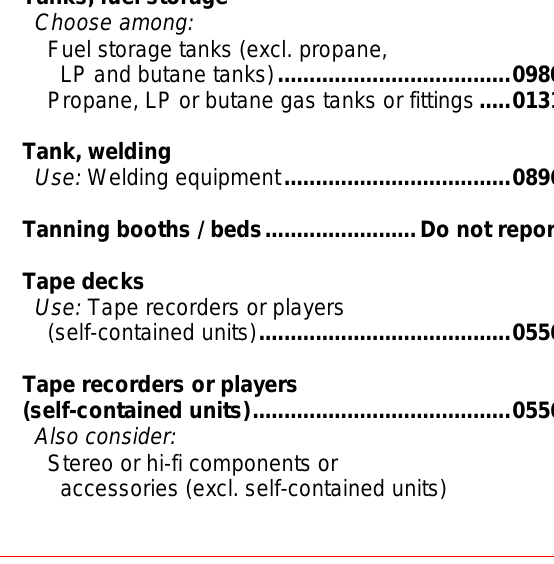
Table hockey / air hockey Use: Toys, not elsewhere classified ................... 1381